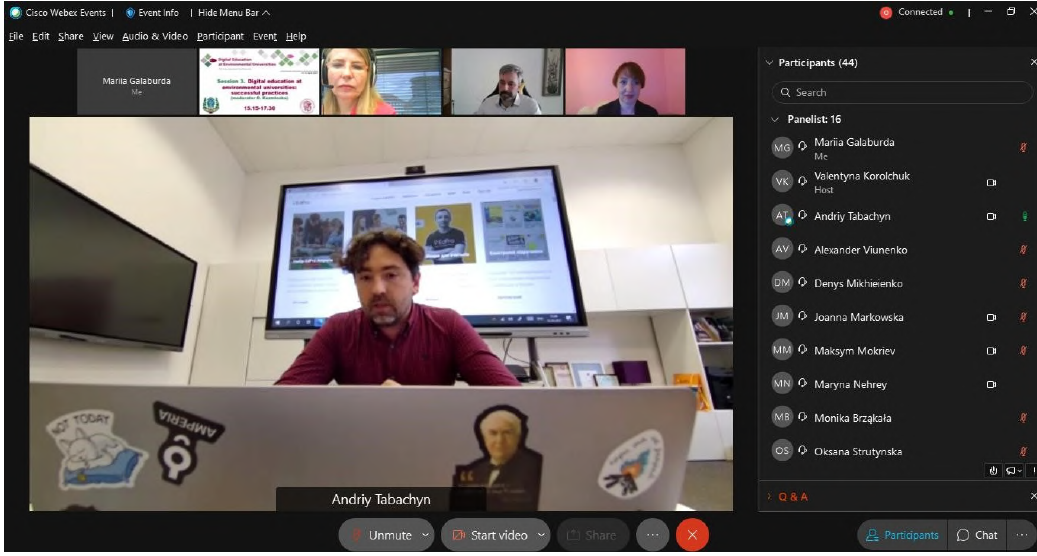
Figure 102: Presentation of paper